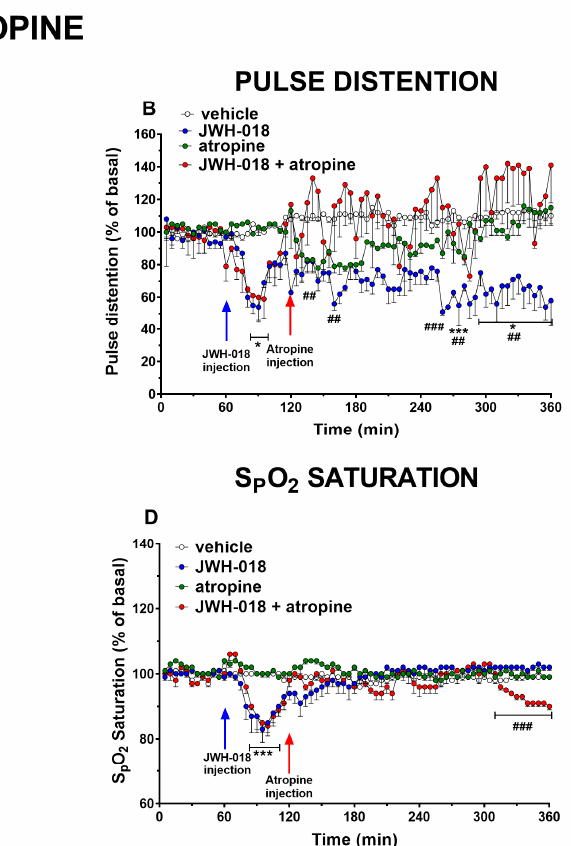
Figure 3. Effect of systemic administration of JWH-018 (6 mg/kg), atropine (5 mg/kg), or JWH-018 followed by atropine on heart rate ( A ), pulse distention ( B ), breath rate ( C ), and arterial oxygen saturation ( D ). Data are expressed as percentage of basal values in the form mean ± SEM of eight different evaluations for each group. Statistical analysis was performed by two-way ANOVA followed by Bonferroni’s test for multiple comparisons. * p < 0.05, *** p < 0.001, JWH-018 versus vehicle. ## p < 0.01, ### p < 0.001 versus JWH-018 + atropine. ◦ p < 0.05, atropine versus vehicle.